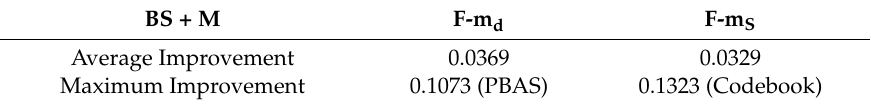
Table 14. Improvement of BS performance caused by median filter.